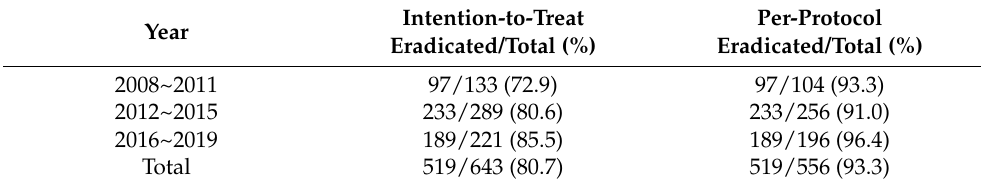
Figure 2. Annual Helicobacter pylori eradication rates of second-line bismuth containing quadruple therapy. ITT, inten- tion-to-treat; PP, per-protocol.